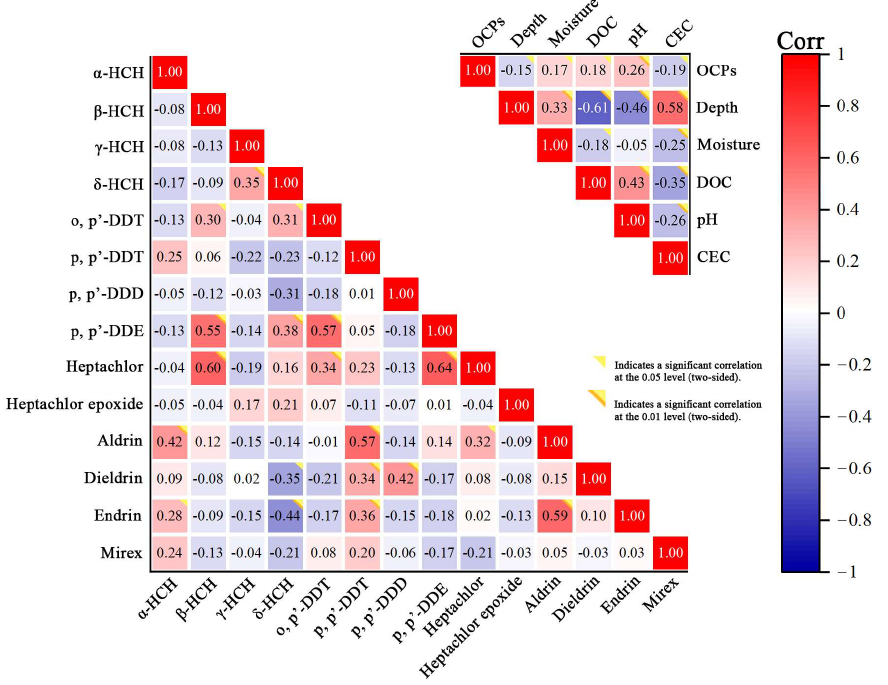
Figure 3. Two-factor correlation analysis between OCPs and soil properties. According to the 2021 Xiamen City Climate Annual Report [29], the annual precip- itation of representative stations in various districts outside Xiamen Island in 2021 are as follows: Tong’an District (1381.3 mm), Haicang District (1062.7 mm), Jimei District (1057.8 mm), Xiang’an District (831.3 mm). Among them, the Tong’an District has the largest proportion of moderate rain and heavy rain, accounting for 16.8% and 10.9%, re- spectively. Compared with the previous analysis of the pollution degree of each region, precipitation does not seem to be the main factor determining the residue of OCPs. Linear regression analysis of soil properties and OCP concentration distribution (Figure 4) revealed that OCPs were positively correlated with water content, dissolved organic carbon, and pH and negatively correlated with cation exchange capacity ( p < 0.05). The linear regression equation and goodness of fit are shown in Supplementary Table S3. In the analysis of